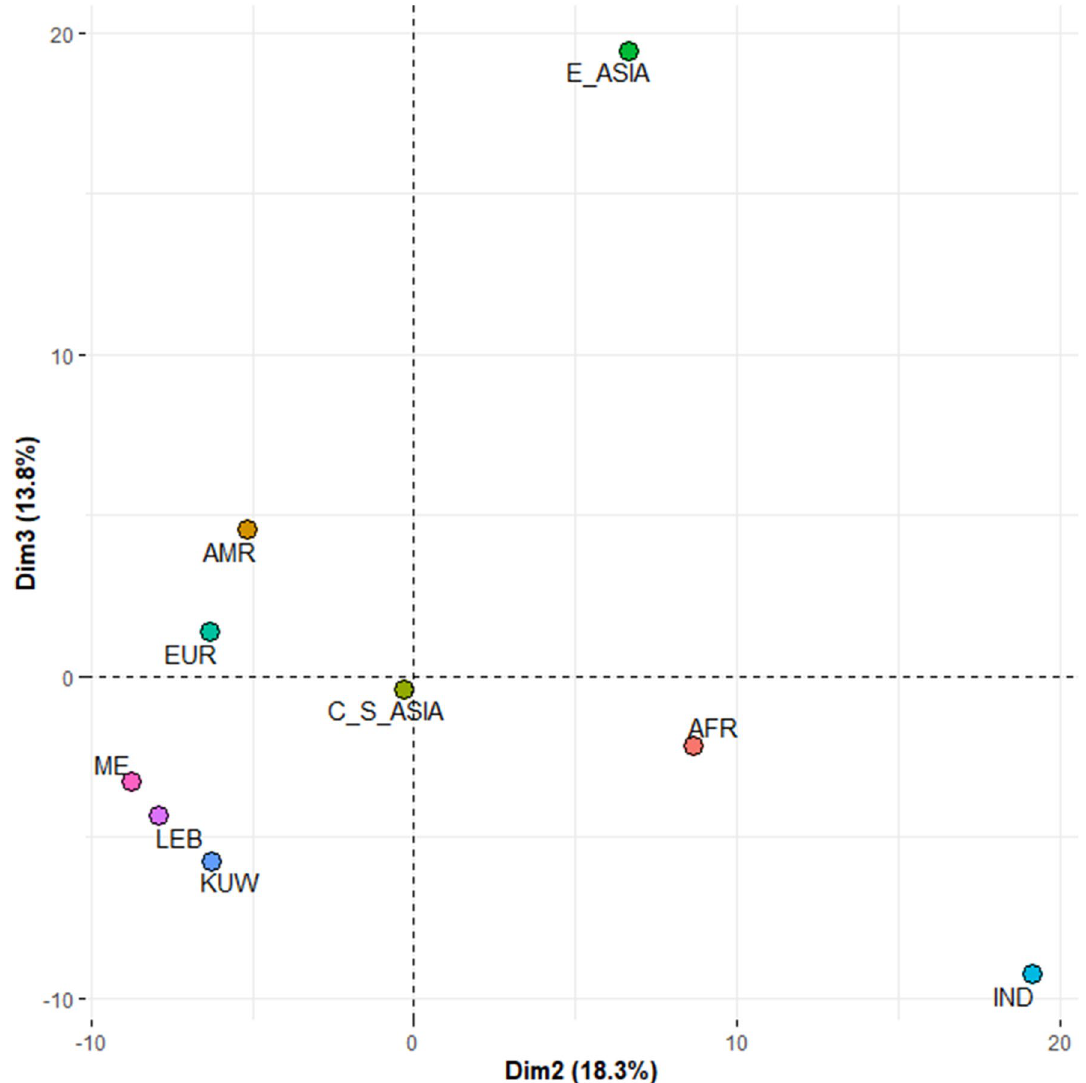
Figure 2. Principal component analysis of genetic distance based on allele frequencies of 23 autosomal PowerPlex Fusion 6C loci shared between the population from Kuwait (KUW; this study) and those from Africa (AFR), America (AMR), Central and South Asia (C_S_ASIA), the Middle East (ME), Europe (EUR), East Asia (E_ASIA), Lebanon (LEB) and India (IND; Madhya Pradesh) (generated using factoextra package 34 in R software 33 eight African (N = 507), six American (N = 551), nine Central and South Asian (N = 202), four Middle Eastern (N = 160), 11 European (N = 2135), and 17 East Asian (N = 227) populations. An Indian population (N = 374) and a Lebanese population (N = 505) were also typed for the 23 loci, thus were added to the analysis. Both PCA and phylogenetic analyses were carried out, and the resulting plots characterise the genetic differentiation between populations. The distribution of the populations on the PCA plot (Fig. 2), and the genetic distances between them on the NJ tree (Fig. 4A) show that the Kuwaiti population is genetically closest to the Leba- nese and Middle Eastern groups, which includes Mozabite, Druze, Palestinian and Bedouin populations. This is explained by the gene flow between these geographically close locations, which consequently leads to more similar allele frequency distributions among them. At the regional level, genetic distance was assessed based on the 13 loci shared between this study and studies examining other populations from the Arabian Peninsula. The resulting PCA plot (Fig. 3), and NJ tree (Fig. 4B) show that our Kuwaiti dataset broadly clustered with the previously published Kuwaiti data, and was genetically closer to the countries in the north of the region such as Iraq and Iran. In contrast, there was a higher level of genetic differentiation between Kuwait and Saudi Arabia, Yemen and Qatar, which were clustered in the upper- right part of the PCA plot, and Bahrain, Oman and UAE, which were clustered in the lower part of the plot. In this study, 30% of individuals declared their origins as being from the north (Iraq and Iran), 39% from the south region (Saudi Arabia, Bedouin and Bahrain), and 24% had parents of different origin (admixed).